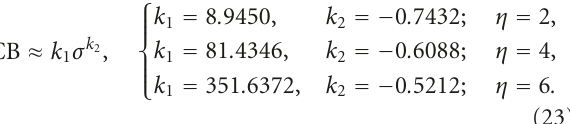
channel remains almost unchanged, and the CB, B c , is